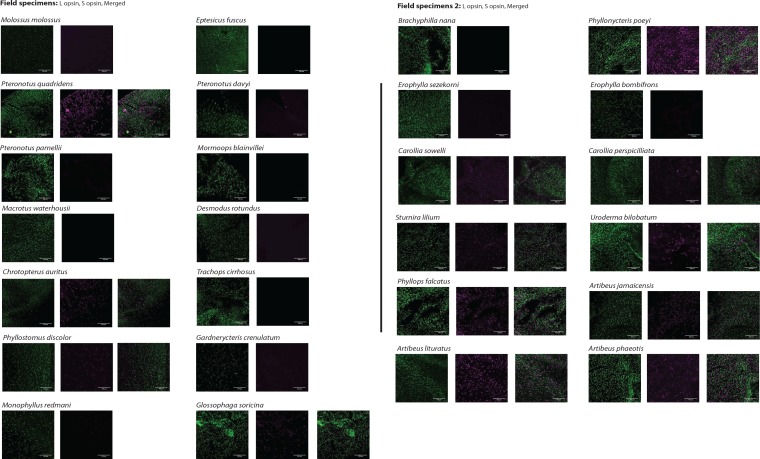
L- and S-opsin protein expression in the L- and S-cones of field samplesL- and S-opsin presence was assayed by IHC on field samples for 26 species with antibodies recognizing each of L- and S-opsin. For each species, L- and S-cone labeling are shown. For species with both L- and S-cones, the merged column is the result of the merged images of L- and S-cones from the same individual. No evidence of dual cones was found. Scale bar: 100 μm.